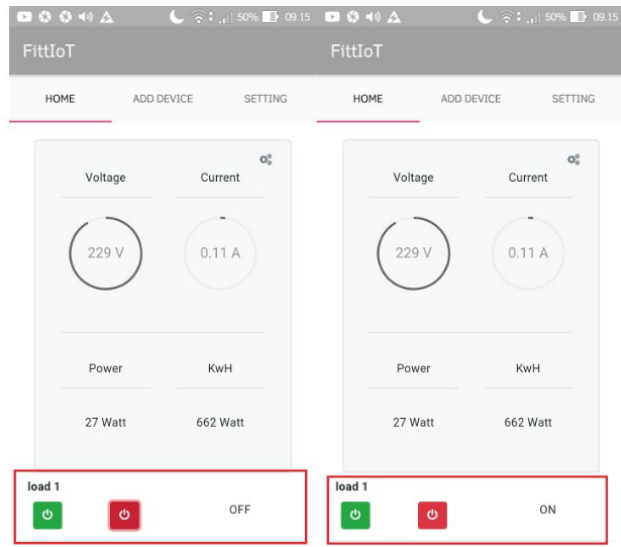
Figure 4. Testing Sensor Data on the main page of